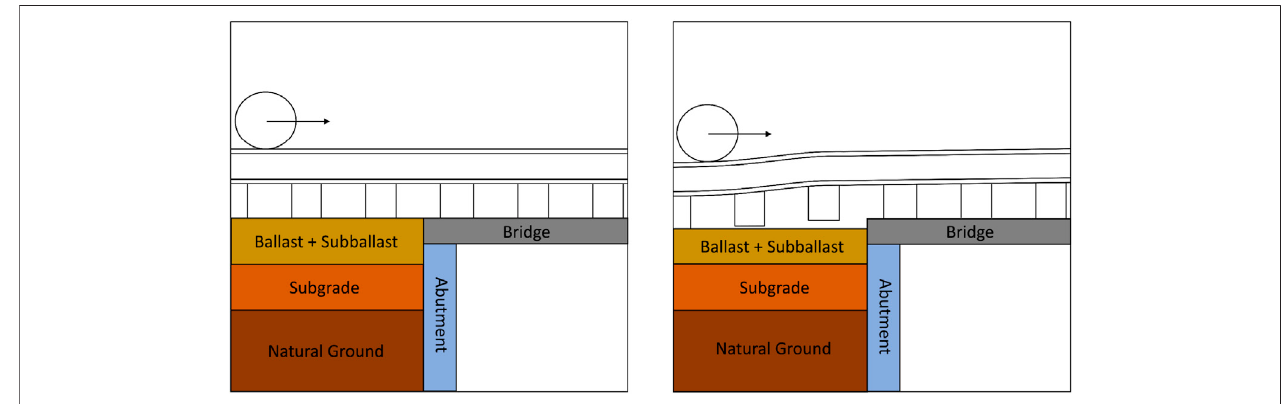
FIGURE 1 | Degradation of track transition